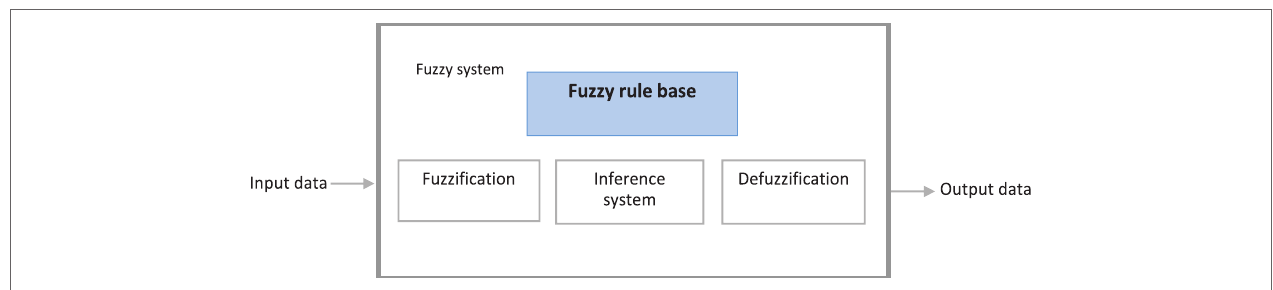
FigUre 3 | Fuzzy inference